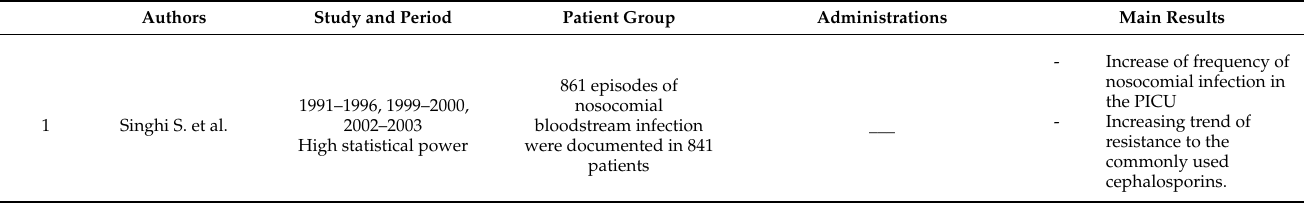
Table 1. Summary of high-power studies supporting the benefit of probiotics in the pediatriac intensive care unit (PICU).